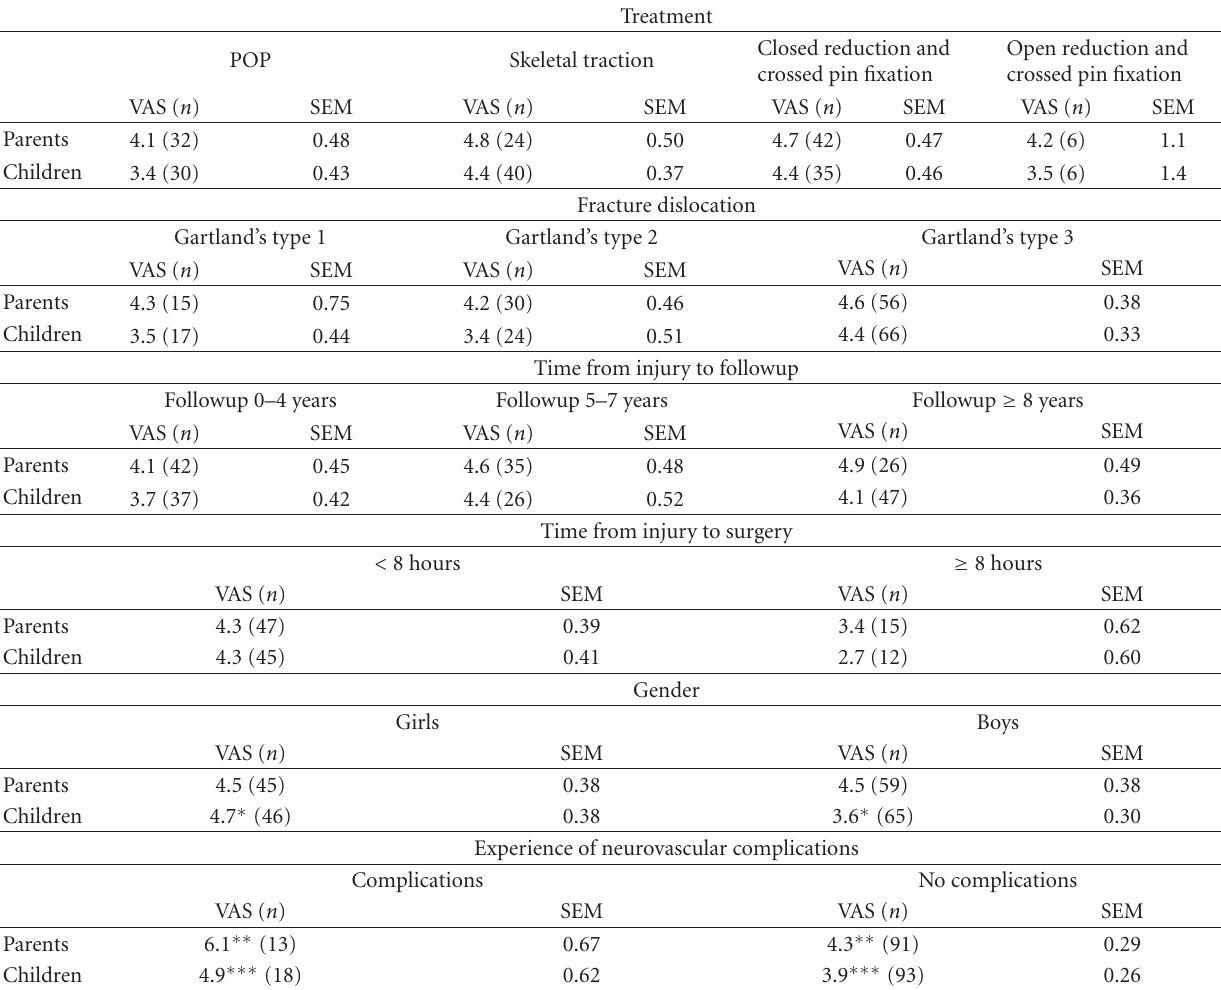
Table 1: Parents’ and children’s rating of experience of being treated for SCHF. VAS scale 0–10. 0 is no negative experience at all, 10 a very negative